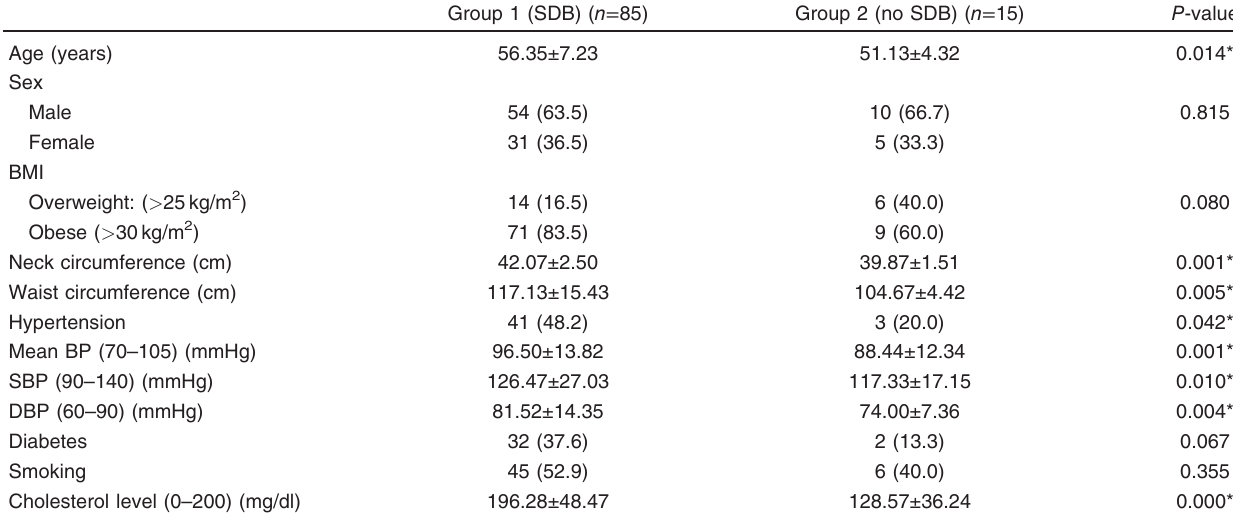
Table 1 Demographic data and clinical examination findings in heart failure patients with sleep-disordered breathing and those without sleep-disordered breathing